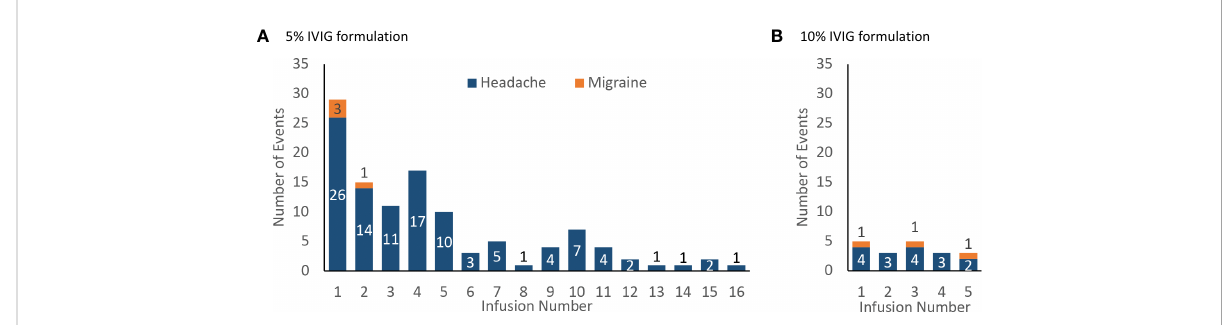
FIGURE 4 Incidence of product-related headache and migraine by infusion number, number of events (A) 5% IVIG formulation (108 patients for weeks 1-5, then 75 patients for weeks 6-18) (B) 10% IVIG formulation (48